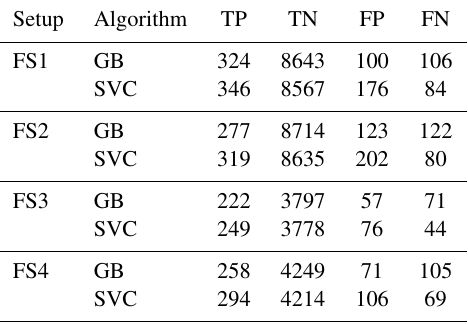
Table 5. Confusion matrix statistics for all four feature setup exper-